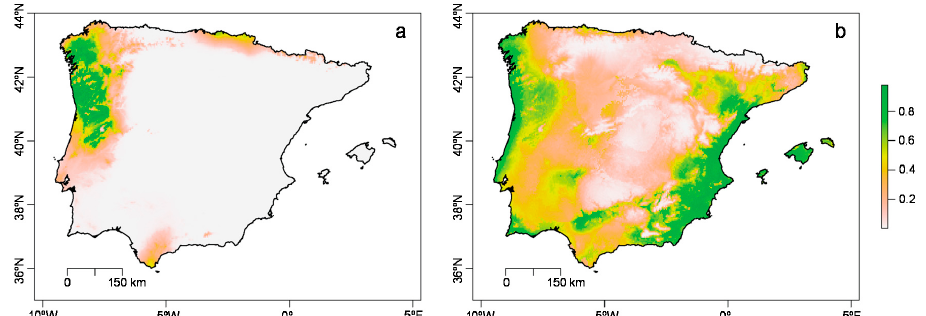
Figure 2. Maxent prediction model for climatic suitability of the huanglongbing vector Trioza erytreae (del Guercio) and its host ( Citrus spp.) in the Iberian Peninsula. ( a ) Trioza erytreae . ( b ) Citrus spp. Colors indicate the gradient of bioclimatic suitability (p). Results are shown for mainland Portugal and Spain and Balearic islands.